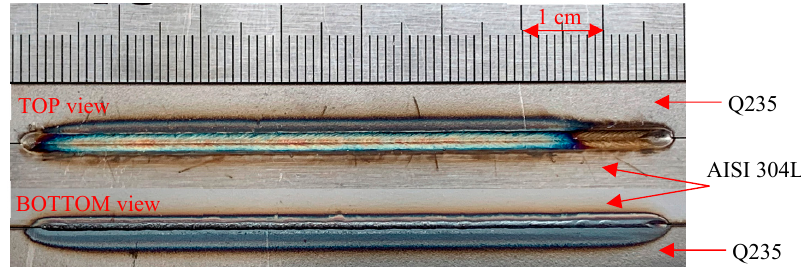
Figure 4. Top weld and bottom weld for laser butt welding of AISI 304L and Q235 steels.